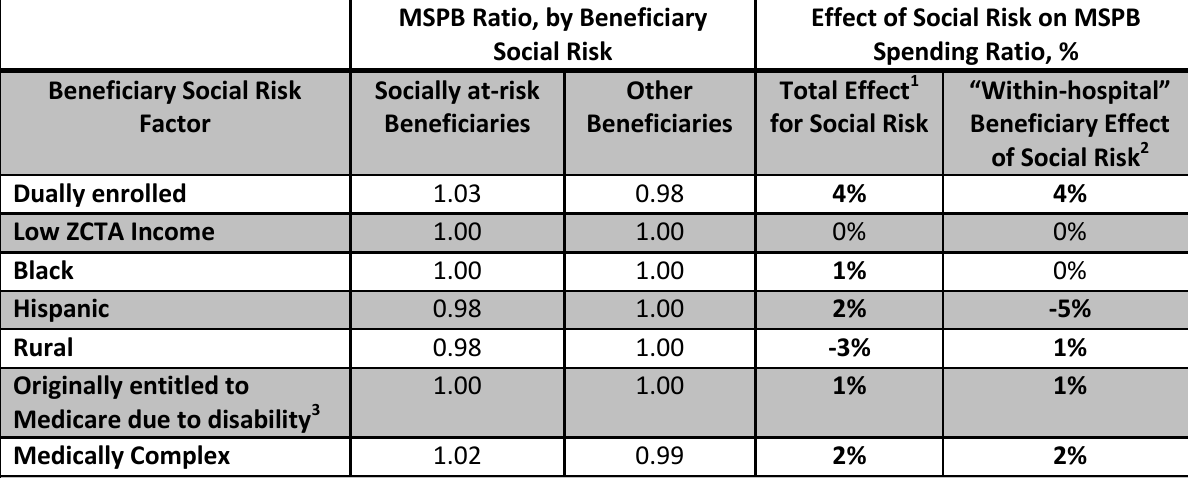
Effect of Social Risk on MSPB Spending Ratio, %